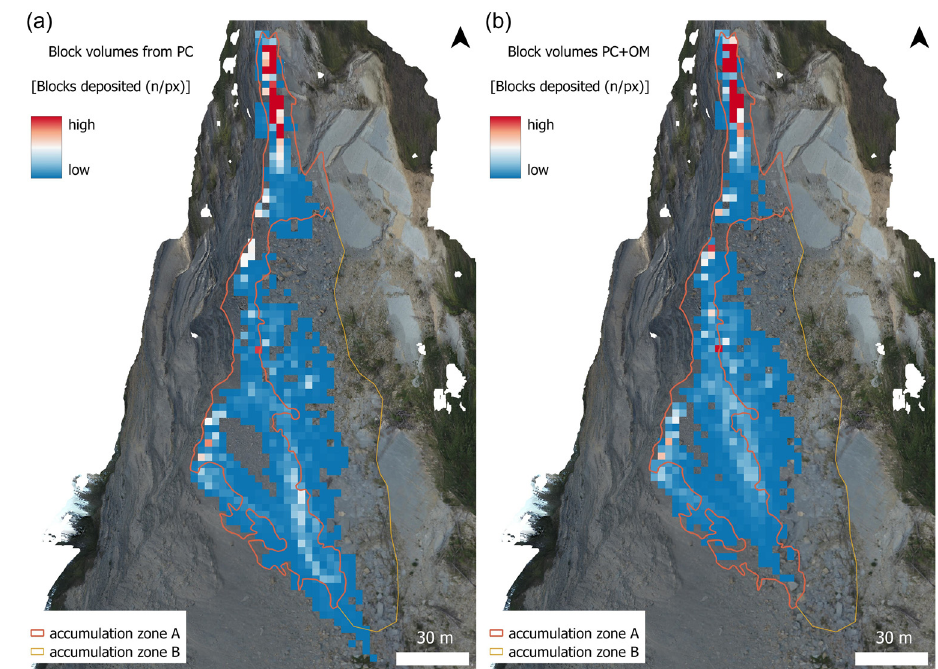
Figure 13. RF3D results, as the number of blocks deposited per pixel. Panel ( a ) shows the simulation results obtained with the volume distribution of the PC analysis, while panel ( b ) shows the results from the PC + OM analysis. Refer to Table 5 for the simulation parameters. Table 5. Simulation characteristics for each source area, with 10,000 trajectories simulated per source pixel.